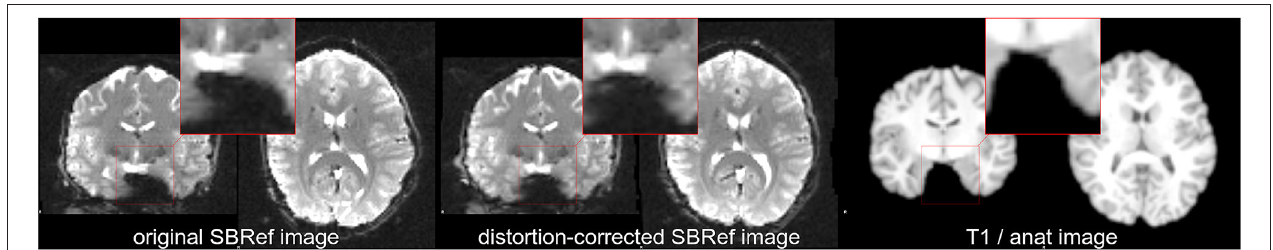
FIGURE 1 | Non-linear mismatch between EPI and T1w image of the same subject of the HCP dataset (Van Essen et al., 2012), before and after distortion-correction. (Left) Single-band high-resolution EPI (SBRef) image of the same subject. Notice the large distortions along the Left-Right direction (inside the highlighted patches). (Center) Distortion-corrected single-band EPI image. Here, the distortion-correction managed to undo most—but not all—of the distortions. Even after distortion correction, there are minor shape differences between the EPI and the T1 image of the subject (Right) . The same native-space coordinates where used in all of the three